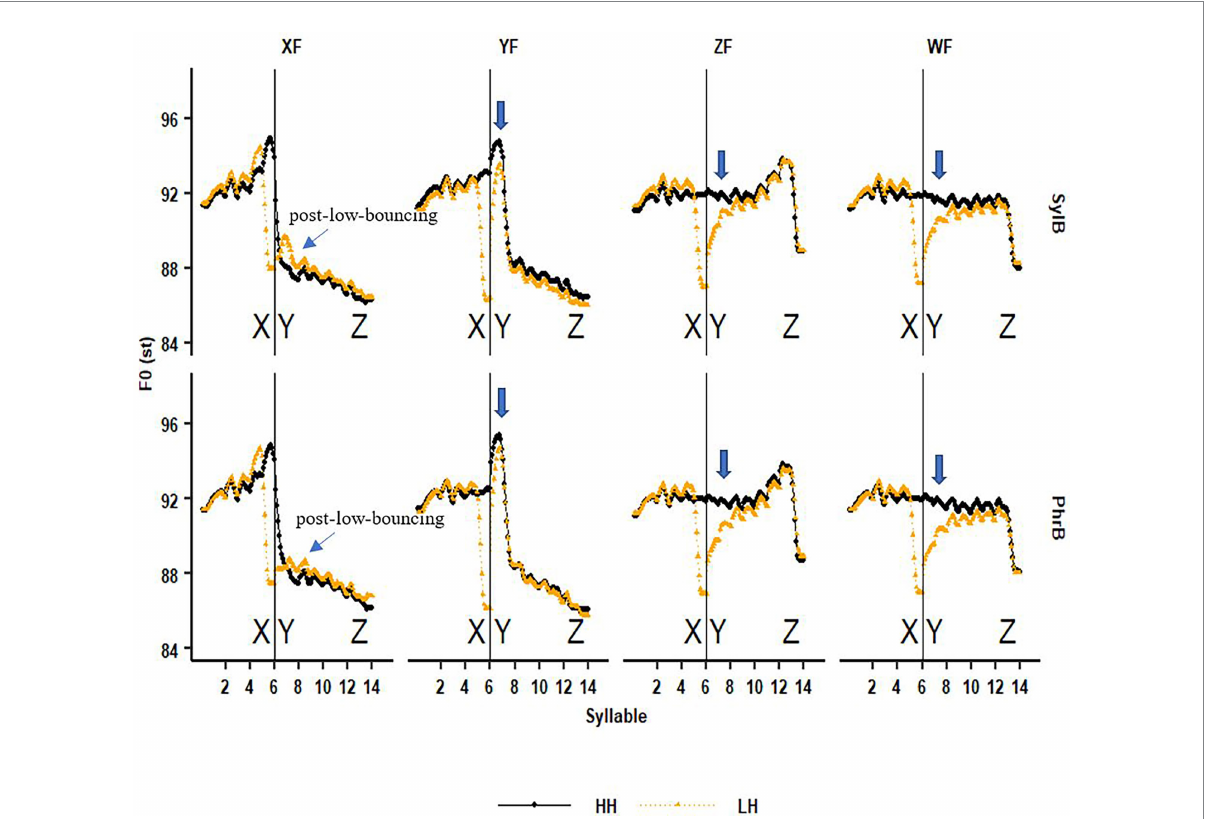
FIGURE 5 The comparison between the HH (black line) and LH (yellow line) sentences in four focus conditions (from left to right are the conditions of focus in syllable X, Y, Z and in wide-focus) under the condition that the boundary between X and Y is a syllable (SylB; upper row) or a phrase boundary (PhrB; lower row), as indicated by the vertical line. The downward arrow indicates where the downstep effect can be